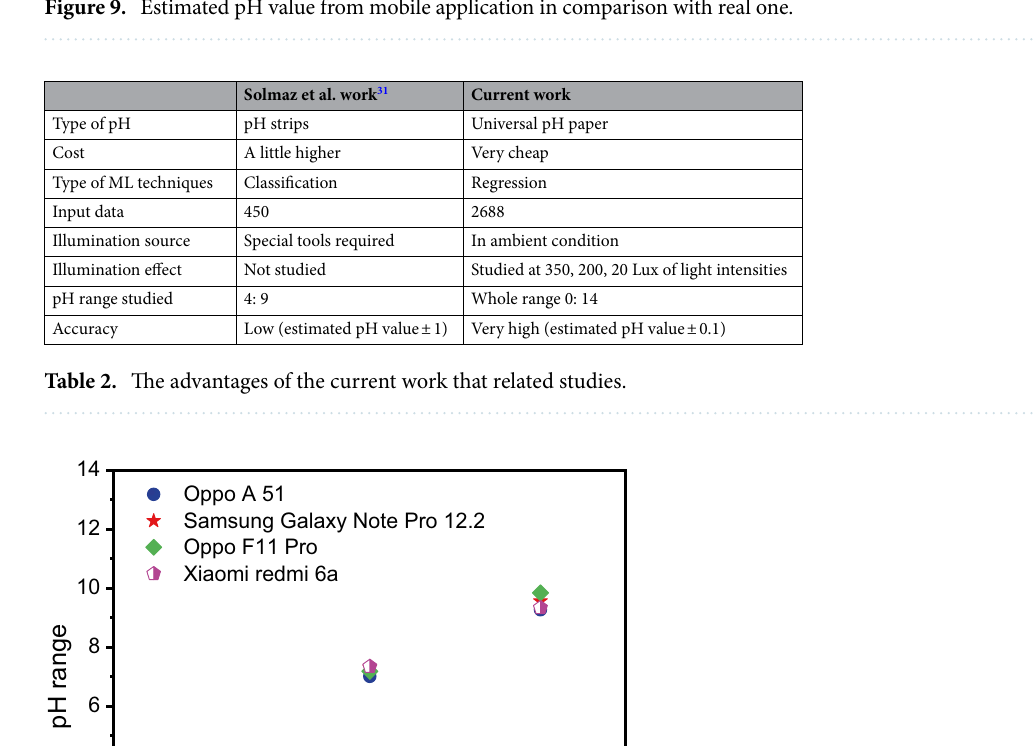
Figure 9. Estimated pH value from mobile application in comparison with real one.